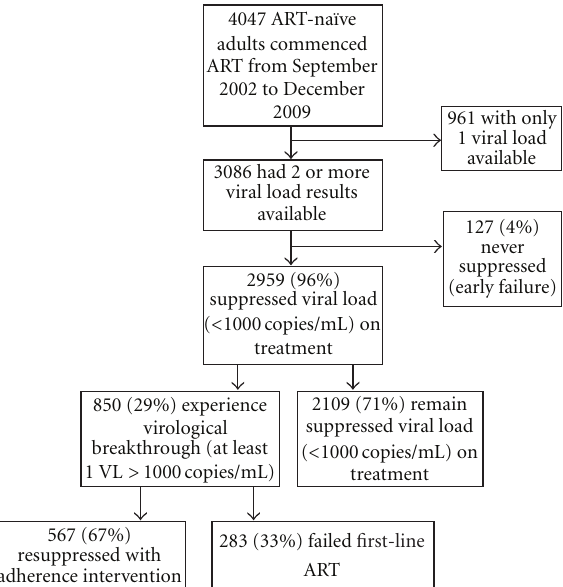
Figure 1: A flow diagram describing the cohort with virological breakthrough ( > 1000copies/mL) as a subset of ART-na¨ıve adults commencing treatment at the HCTC and subsequent outcomes.